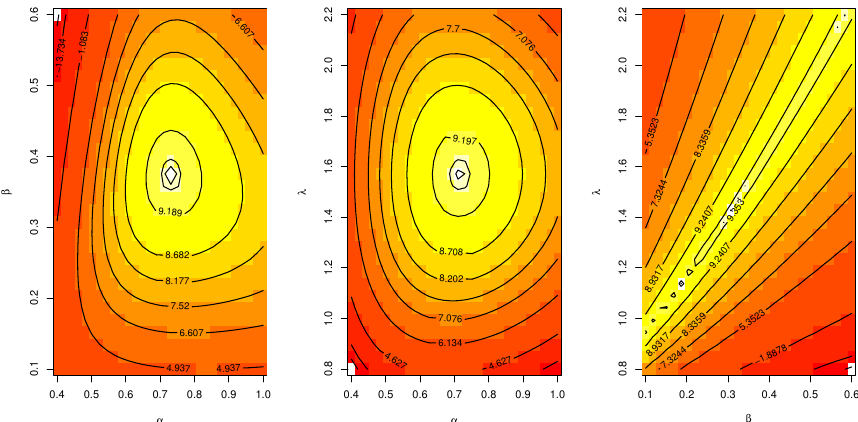
Figure 14. Profile likelihood of UEPD for the failures of 20 components data.